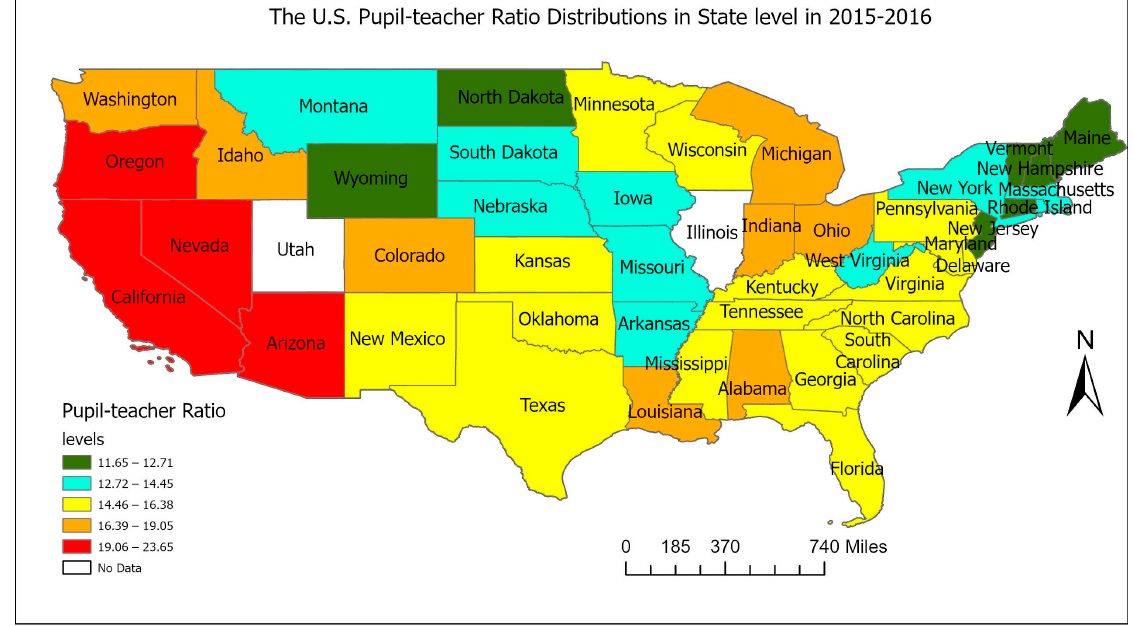
Figure 5. Student–teacher ratio displayed at state level.